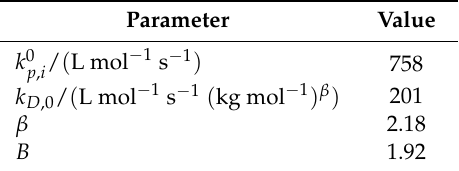
Table 6. Estimated parameter values of the parameter optimization carried out by fitting the model equations to the experimental data of conversion versus time (cf. Figures 9–11) for the fully ionized MAA